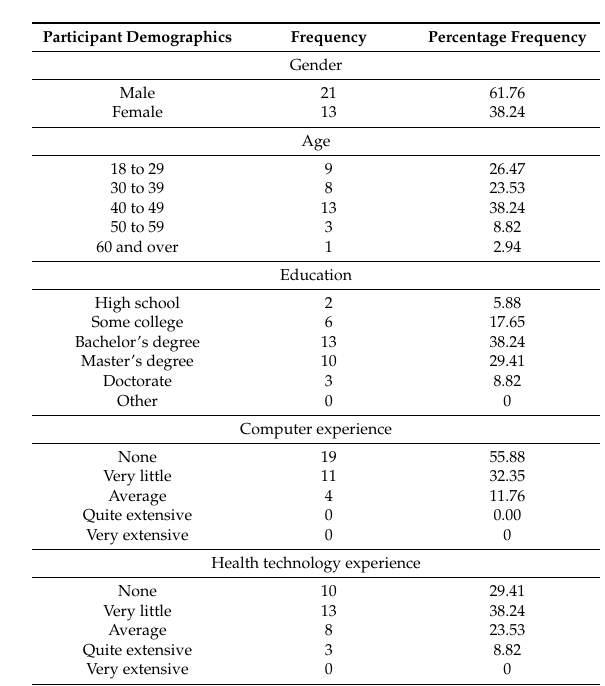
Table 1. Demographics of diary study participants ( n =